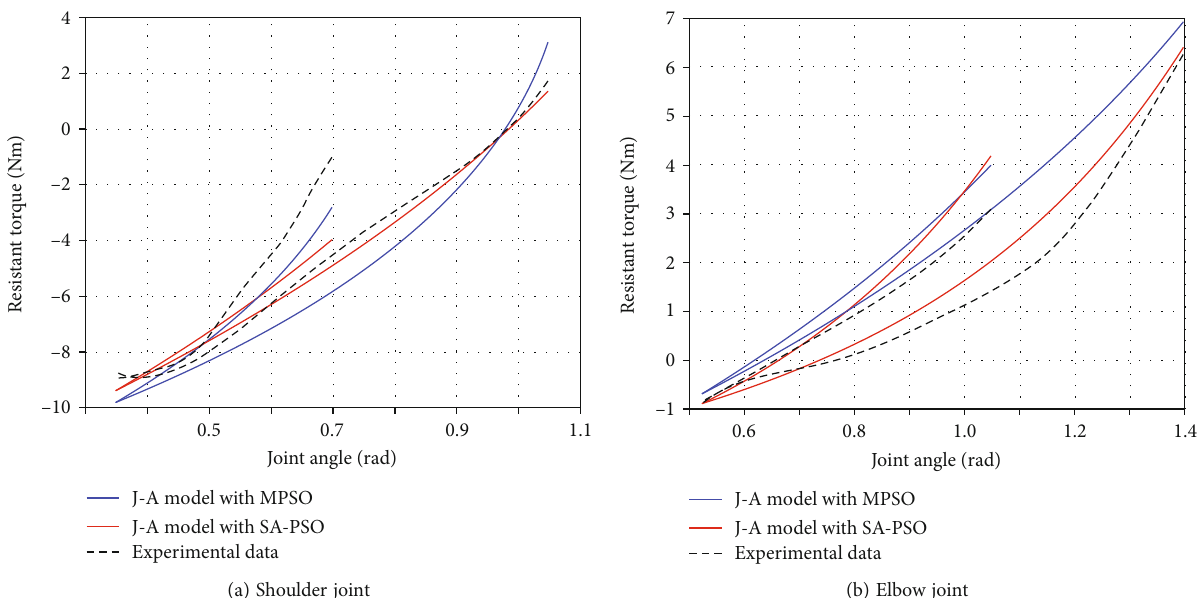
Figure 7: Comparison of resistant torque between upper limb joints ’ experimental data and the J-A model with di ff erent PSO algorithms.